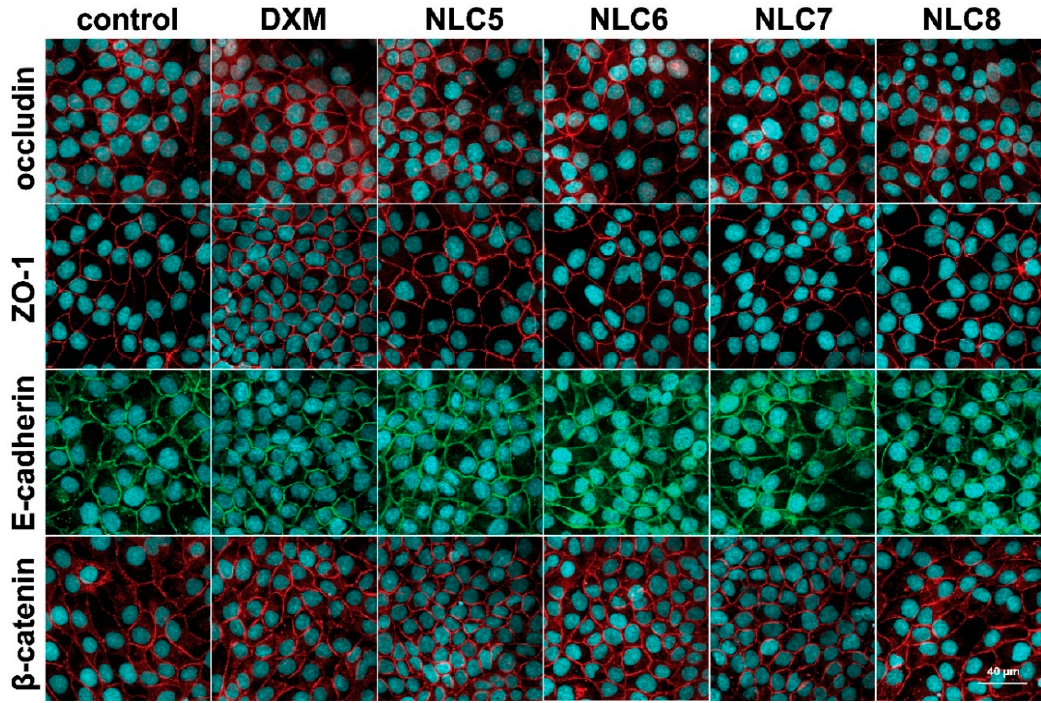
Figure 5. Effects of DXM alone and in formulations (10-times dilution) on junctional morphology of HCE-T corneal epithelial cells. Immunostaining for tight and adherens junction proteins occludin, zonula occludens-1 (ZO-1), E-cadherin and β -catenin after 1-h treatment. Red and green colors: immunostaining for junctional proteins. Blue color: staining of cell nuclei. Bar: 40 µm.